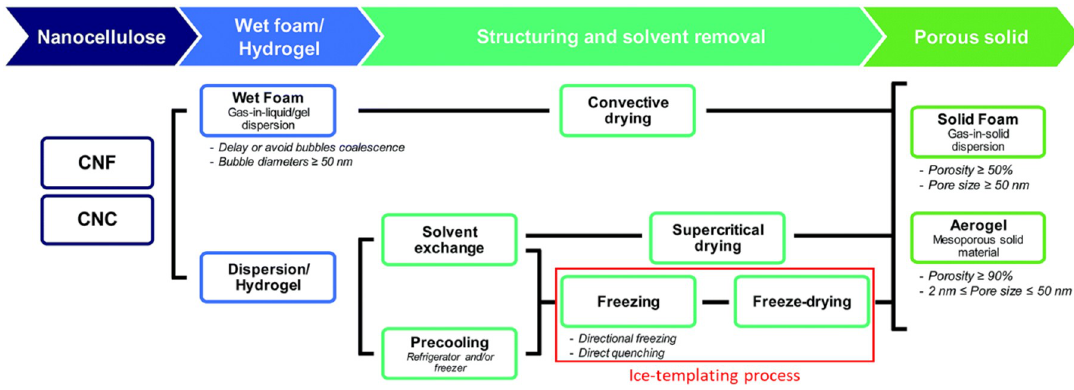
Figure 2. Schematic view of the different processing routes used to obtain nanocellulose-based aerogels and foams. (Adapted from Lavoine and Bergström [52] with permission from the Royal Society of Chemistry); CNF: cellulose nanofibril, CNC: cellulose nanocrystal.